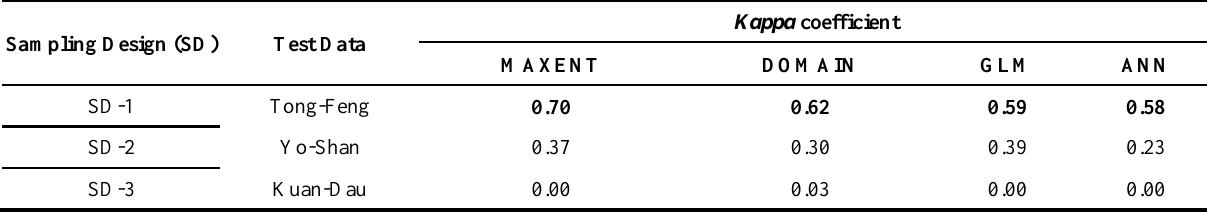
Table 3. Comparison of the accuracies of four models for predicting CGTs potential habitats with three sets of test data